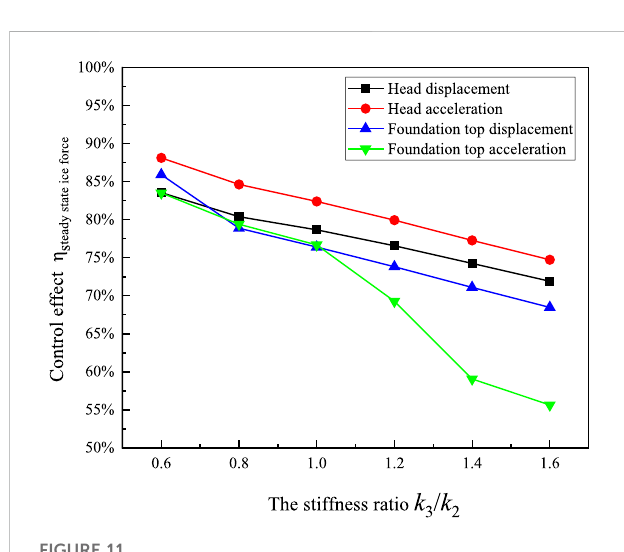
FIGURE 11 The control effectiveness of different stiffness ratios under steady- state ice